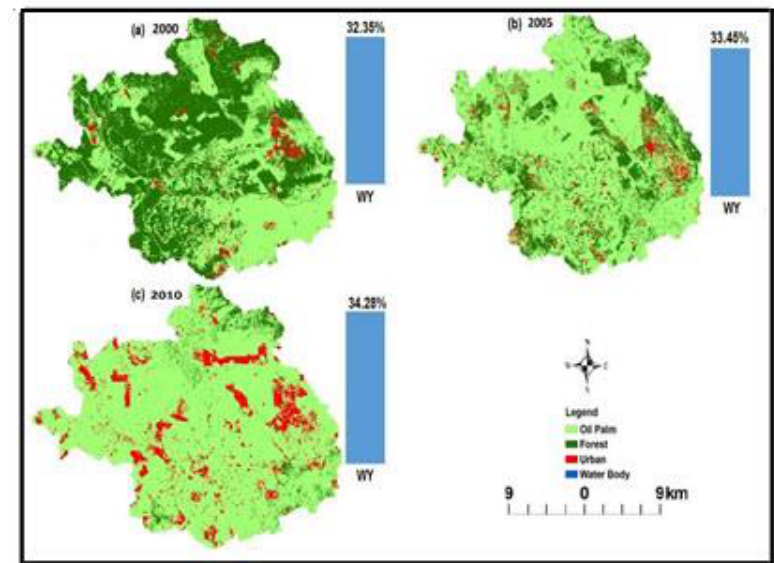
Figure 3. Land Use Classes and WY (a) 2000, (b) 2005 and (c) 2010